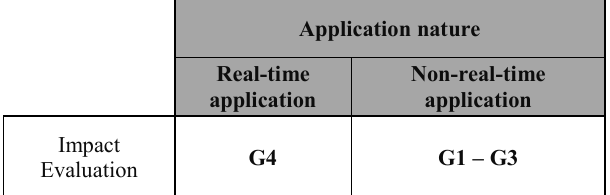
Table 5. Impact of all the studied attack classified by intervention time